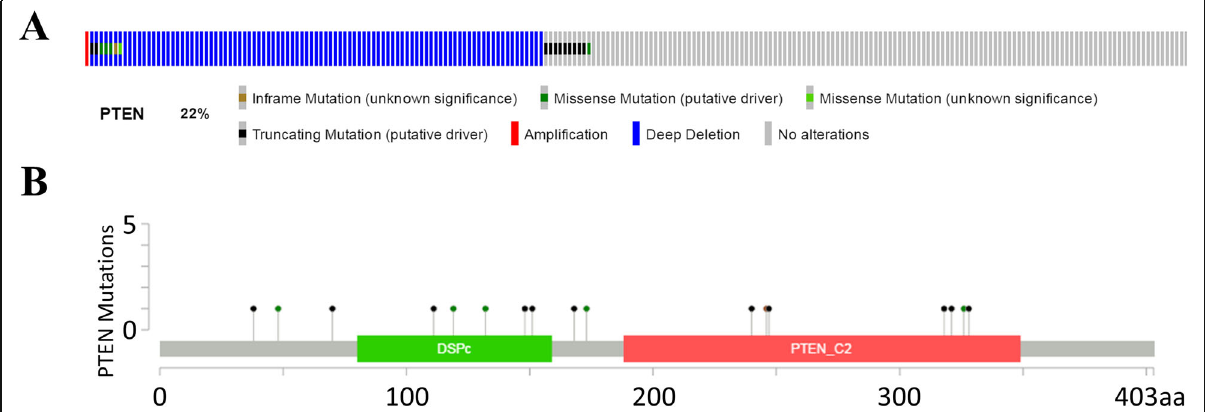
Fig. 1 PTEN mutation frequency and types in prostate cancer. A. PTEN mutation frequency in prostate cancer. B. Mutation types of PTEN in prostate cancer. All data were downloaed directly from